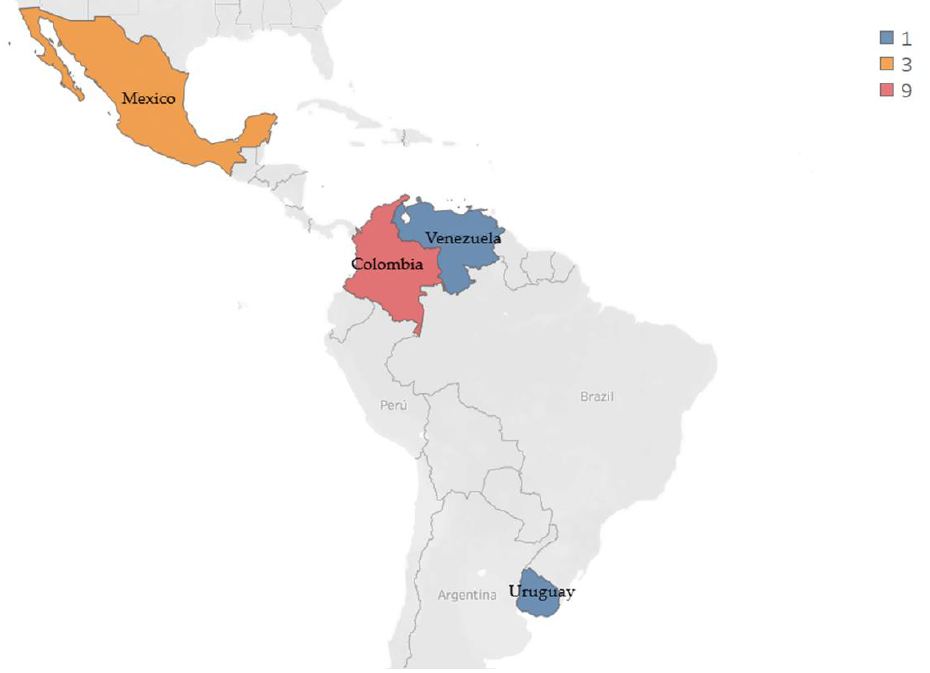
Figure 4. Geographical distribution of the experiences of social appropriation of knowledge (SAK).